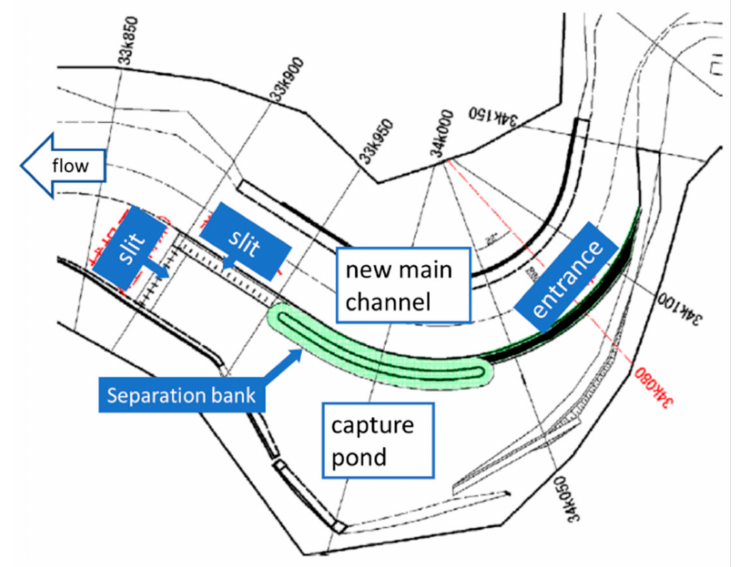
Figure 6. Plan view of optimized structure of driftwood capture